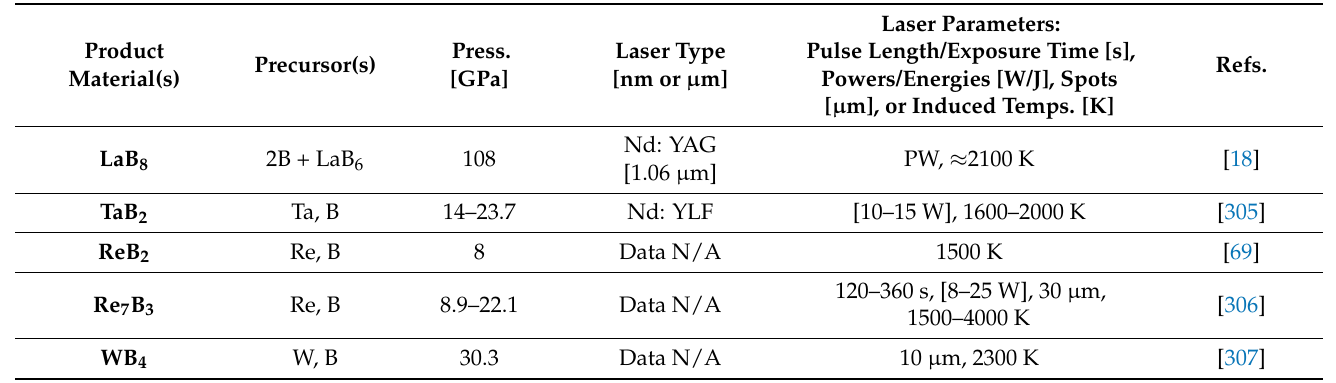
Table 3. Binary Metal Borides: Metal Borides Synthesised During Selected LRS-DAC Studies.